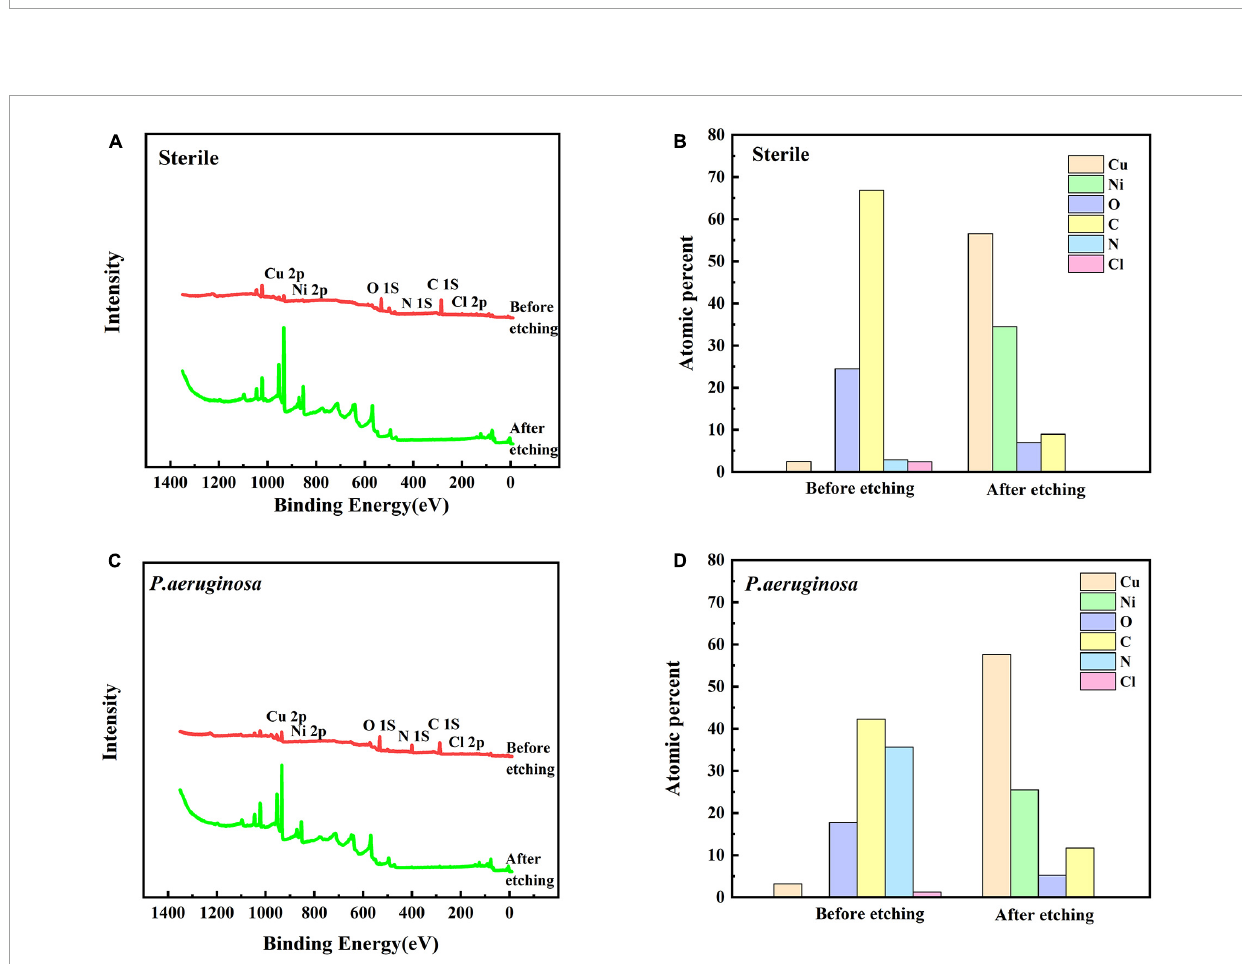
FIGURE6 X-ray photoelectron spectroscopy (XPS) profiles (A) and (C) of B30 copper–nickel alloy immersed in different media for 21 days before and after sputtering, and depth distribution of elements on the film surface (B) and (D)